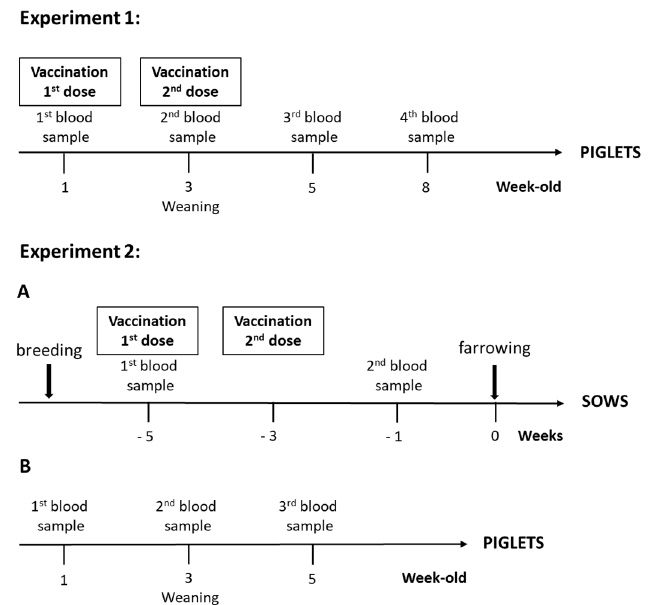
Figure 1. Experimental design of the field study. Experiment 1: Piglets from non-vaccinated sows were vaccinated during the first week at 4 days ± 2 and at weaning with the autogenous vaccine (containing S. suis serotype 7). Blood samples were collected from randomly chosen piglets at 1, 3, 5 and 8 weeks of age. Control (including placebo animals) were also included. Experiment 2: ( A ) Sows were at their parity 0 and received two doses of autogenous vaccine (containing S. suis serotypes 7 and 9) intramuscularly at 5 and 3 weeks before farrowing. Blood samples were taken from all enrolled sows prior to vaccination at 5 weeks before farrowing and at 1 week before farrowing (2 weeks after the 2nd vaccine dose). ( B ) Randomly selected piglets from vaccinated and non-vaccinated sows were sampled at 1, 3 and 5 weeks of age.